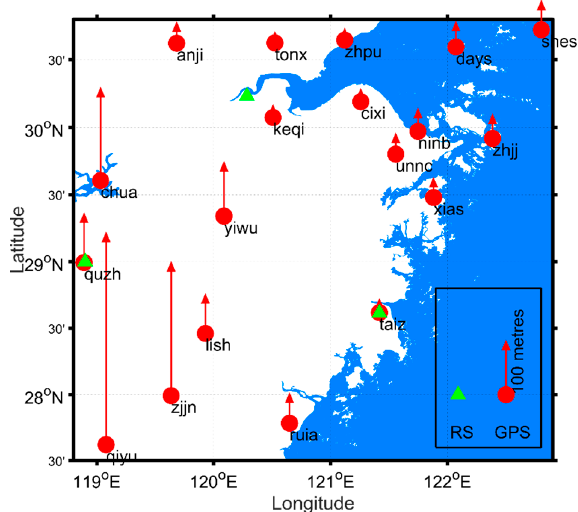
Figure 1. Location of continuously operating reference stations (CORS) (red dots), radiosonde stations (green triangle markers), and global navigation satellite system (GNSS) antenna WGS-84 geodetic ellipsoid height. GPS—global position system.